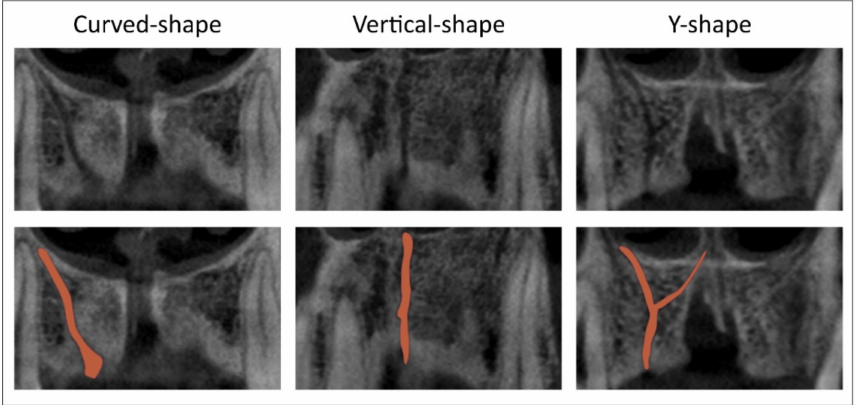
Figure 2. CBCT slices and marks of interest. Accessory canal shapes at the coronal cross-section ( upper ); red marks define ACs shapes at the coronal cross-section ( below ).